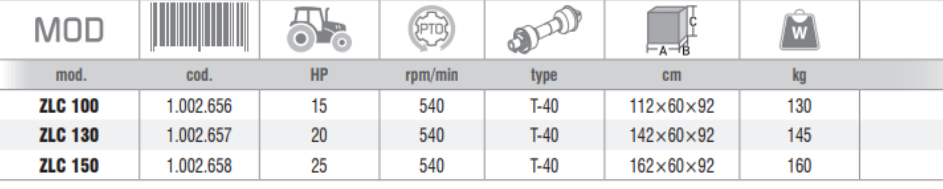
Figure 1. Data from